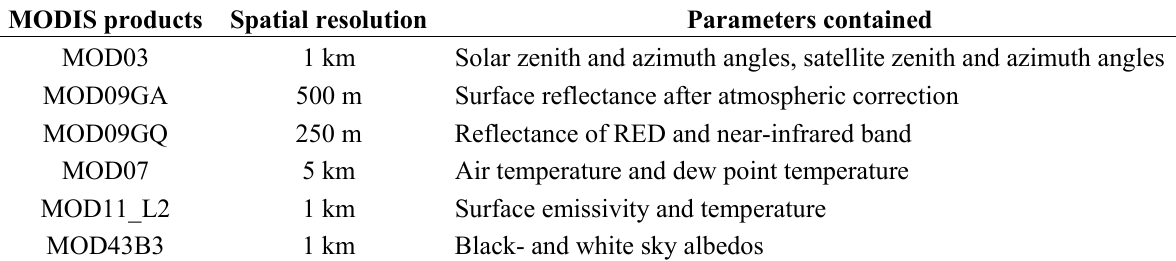
Table 1. List of the Moderate Resolution Imaging Spectroradiometer (MODIS) products used in this